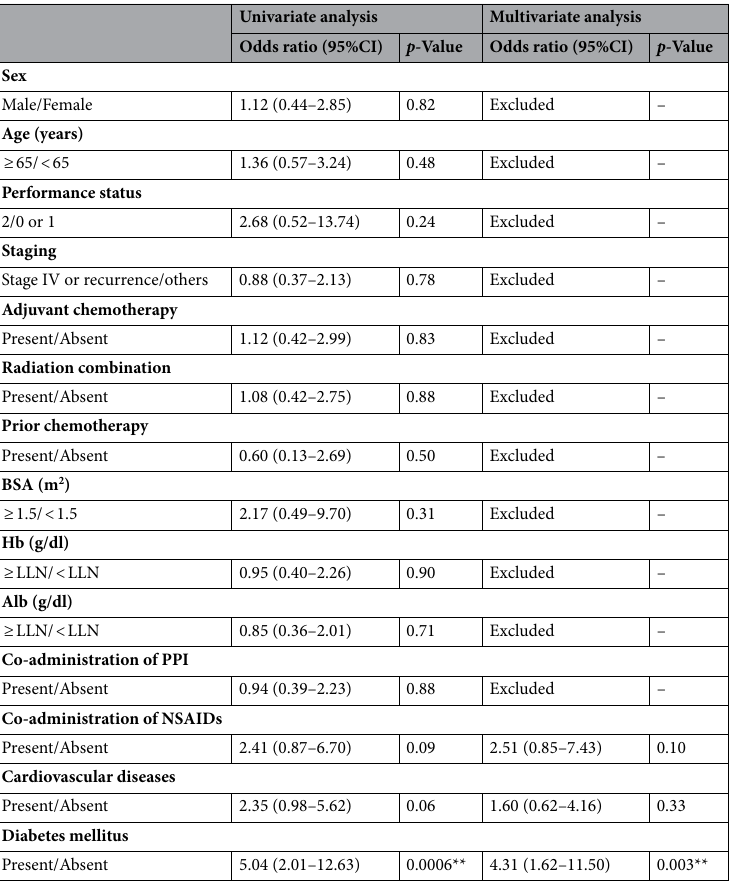
Table 3. Univariate and multivariate analyses of the risk factors associated with the incidence of CIN in all-patient population. ** P < 0.01. BSA body surface area, Hb hemoglobin, LLN lower limit of normal, Alb albumin, PPI proton pump inhibitor, NSAIDs non-steroidal anti-inflammatory